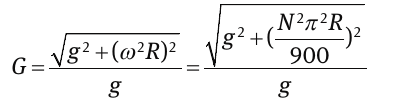
Fig. 2, with the heating furnace and the counterweight fixed symmetrically onto the horizontal rotor. The tem- perature was controlled by a program controller with an R type thermocouple, within the observed precision range of ± 3 K. The gravity coefficient was calculated as the ratio of super-gravitational acceleration to normal- gravitational acceleration via Eq. (1):